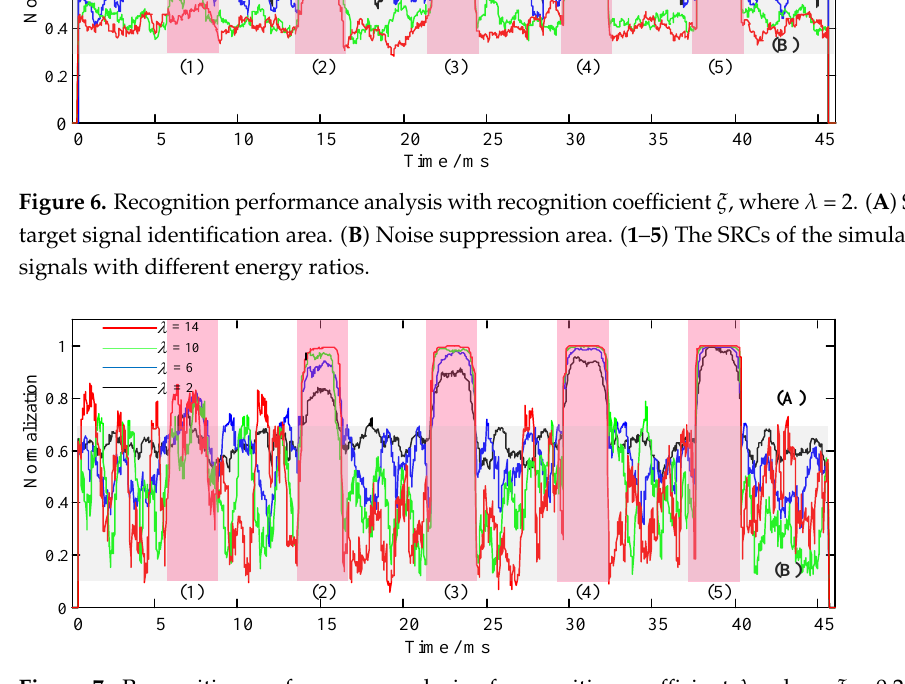
Figure 7. Recognition performance analysis of recognition coefficient λ , where ξ = 0.2. ( A ) The simulated target signal identification area. ( B ) Noise suppression area. ( 1 – 5 ) The SRCs of the simulated target signals with different energy ratios.